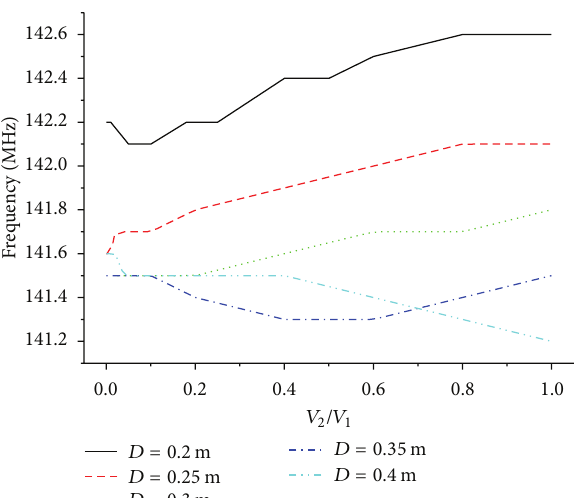
Figure 17: Optimum phase difference, voltage ratio, and frequency for maximum efficiency PTE mat against separation 𝐷 .